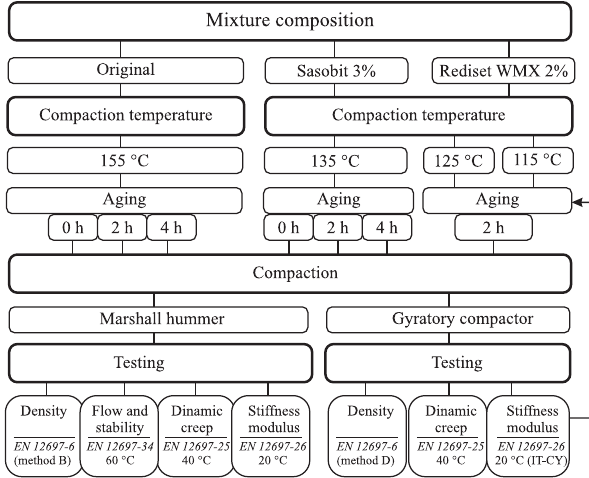
Fig. 5. Experimental plan for testing asphalt